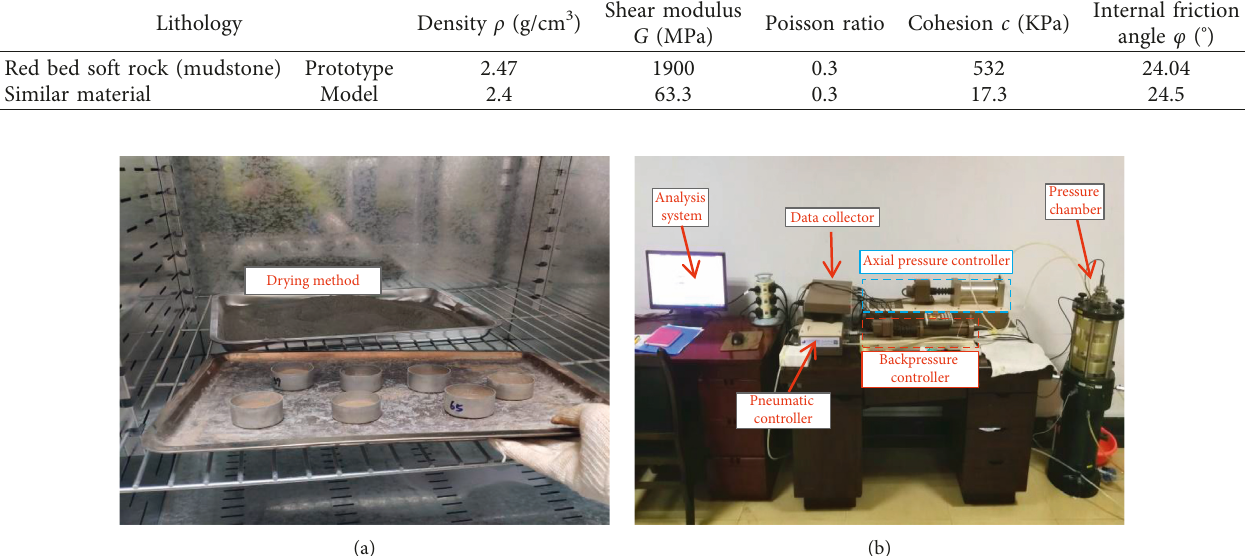
Figure 5: Photos of indoor geotechnical tests. (a) Drying method. (b) Triaxial test.